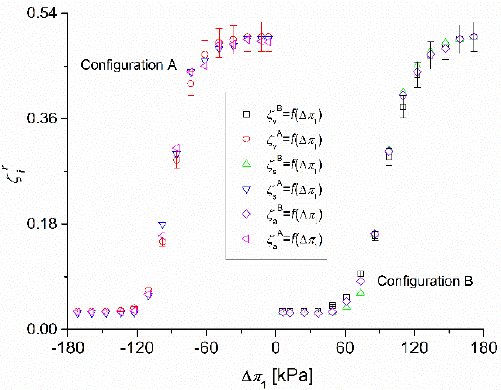
Figure 4. Coefficients ζ r v , ζ r and ζ r ( k = 1, 2 and r = A, B) as functions of osmotic pressure difference of glucose ( ∆ π 1 ) with a constant osmotic pressure of ethanol ( ∆ π 2 = 490.3 kPa) and ∆ P = 0.